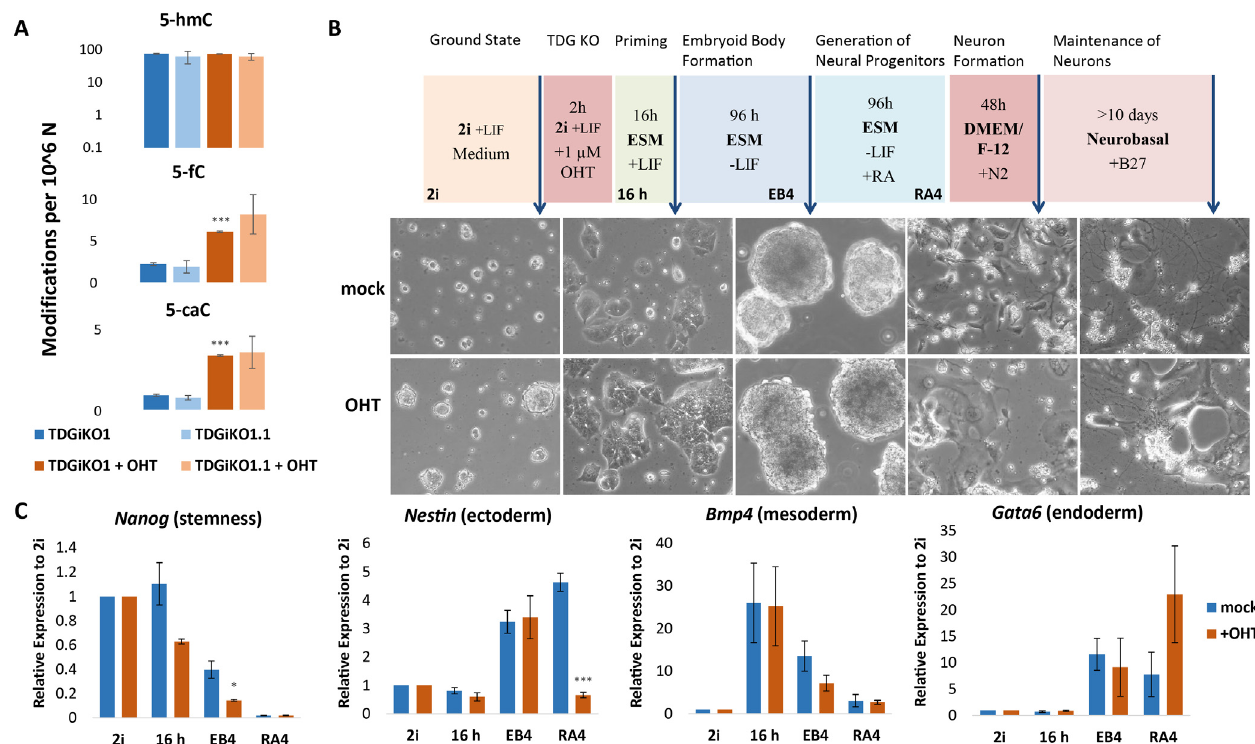
Figure 3. TDGiKO ESCs express a functional TDG and are proficient for cell lineage commitment. ( A ) Measurement of oxidized derivates of 5-mC in selected ESCs by HPLC-MS/MS, cultivated in 2i medium + LIF, one week after TDG depletion by 1 µM of OHT for 2 h. Shown are the means and standard deviation of 2-3 biological replica per condition. ( B ) Scheme of the neural differentiation protocol ( Bibel et al., 2007), adapted with a 16 h priming step in ESC medium for ESCs grown in 2i medium. Representative phase-contrast images of TDGiKO1 cells with (+OHT) and without (mock) TDG depletion at the differentiation stages indicated (arrows). ( C ) Expression of pluripotency and germ layer marker genes were assessed by qRT-PCR in TDGiKO1 cells at the stages of differentiation as marked in ( B ). Expression was normalized to the housekeeping genes Rps13 and Eef1a1 . Shown are means and standard errors of 3 biological replicates. Asterisks indicate p -values of Student’s t-test, compared to the non-induced condition: * p -value < 0.05, *** p -value < 0.001. See Underlying data for the raw data behind this figure (Schwarz,